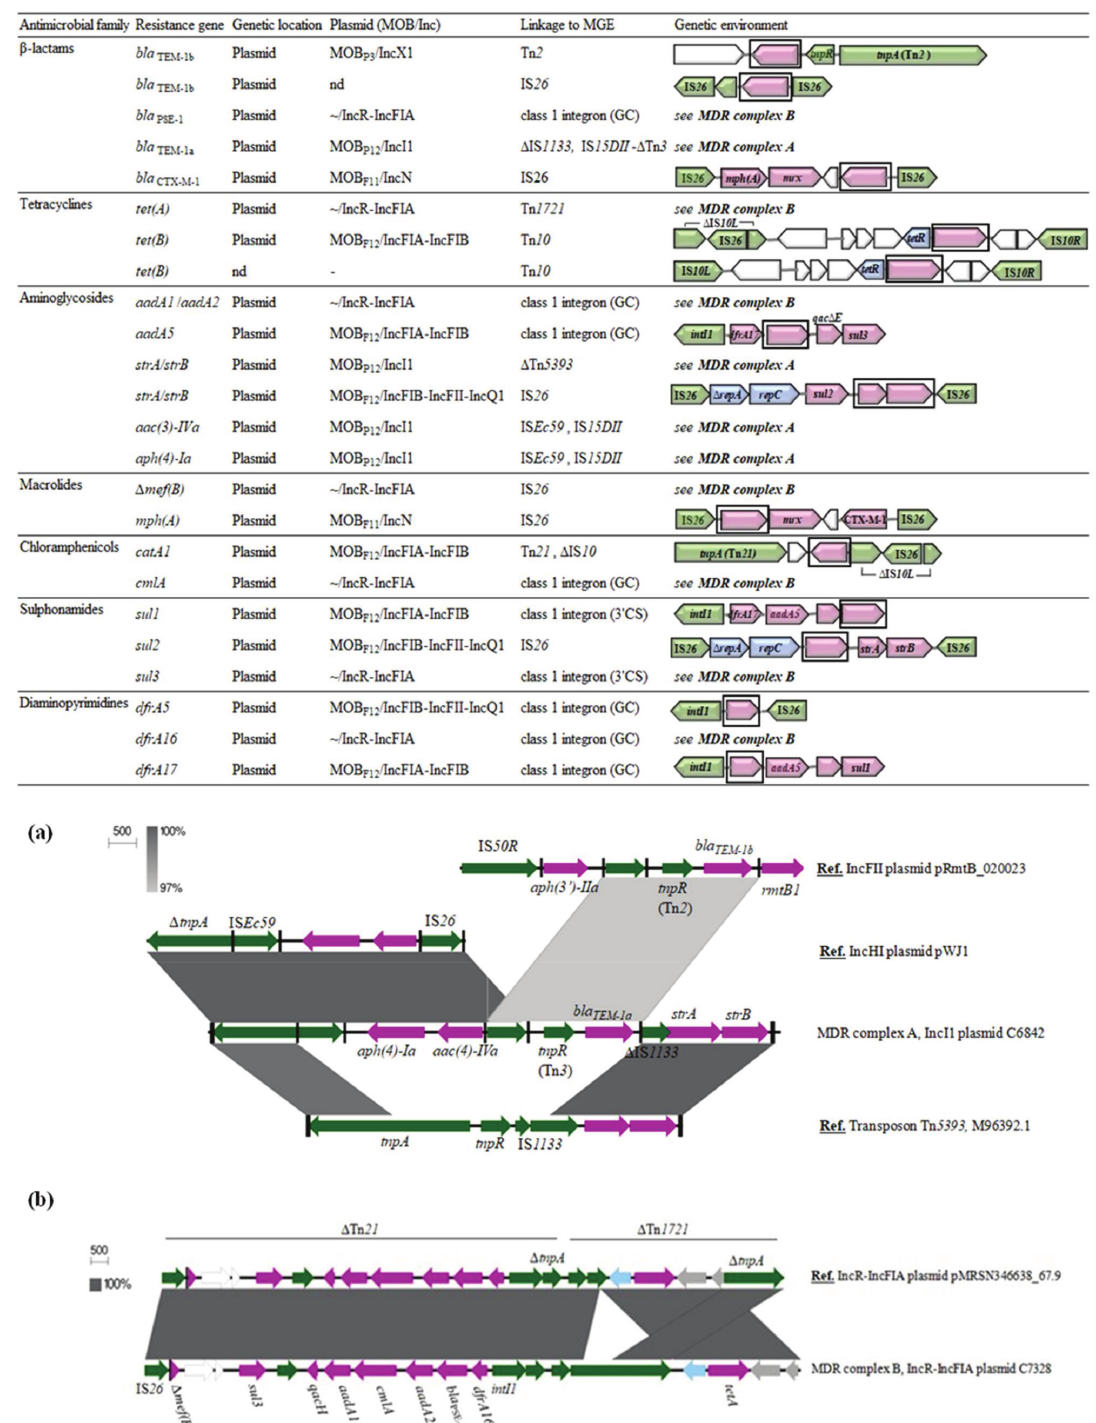
Figure 3. Genetic environment and location of antimicrobial resistance determinants identified in E. coli from wildlife. ( a ) BLAST comparison of the novel resistance complex ∆ Tn 5393 - bla TEM-1a - strA - strB (MDR complex A) with other reference sequences from public databases; ( b ) BLAST comparison of a hybrid Tn 21-1721 transposon carrying an atypical class 1 integron and tet (A) in non-conjugative IncR-IncFIA plasmids (MDR complex B). Genes are colored according to their function: purple, resistance to drug or metal; green, recombination/transposition; blue, replication and regulation of gene expression; grey, known function; white, unknown